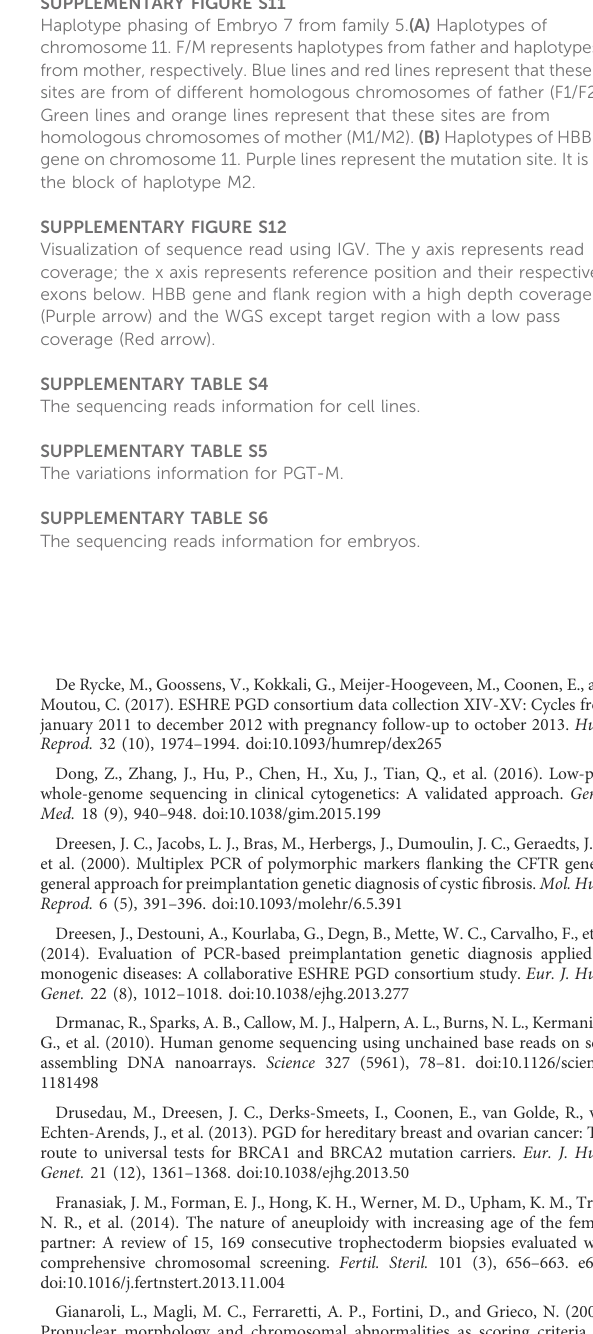
SUPPLEMENTARY FIGURE S11 Haplotype phasing of Embryo 7 from family 5. (A) Haplotypes of chromosome 11. F/M represents haplotypes from father and haplotypes from mother, respectively. Blue lines and red lines represent that these